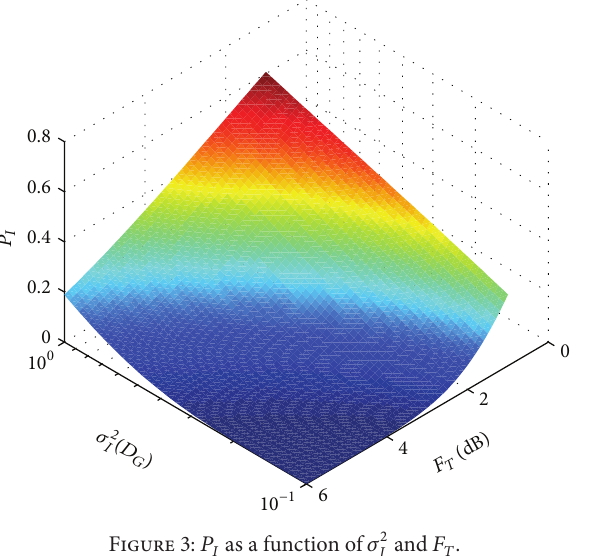
Figure 3: 𝑃 𝐼 as a function of 𝜎 2 𝐼 and 𝐹 𝑇 .